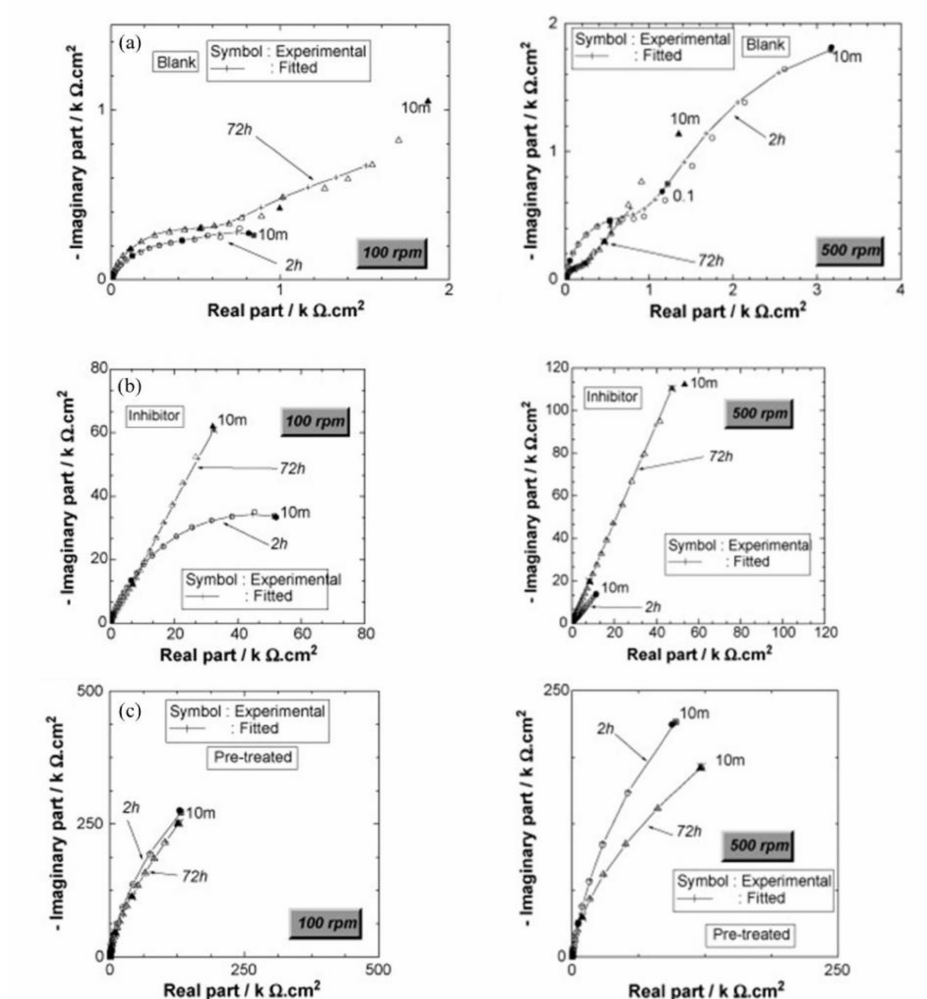
Figure 6. Impedance diagrams (Nyquist representation) of ( a ) steel electrode/S 1 solution, ( b ) steel electrode/S 2 solution and ( c ) pretreated steel electrode/S 1 solution; for two periods of immersion: 2 and 72 h and for two electrode rotation rate values: 100 and 500 rpm [45]. Reproduced with permission from Etteyeb, N. et al., Electrochim. Acta; published by Elsevier,